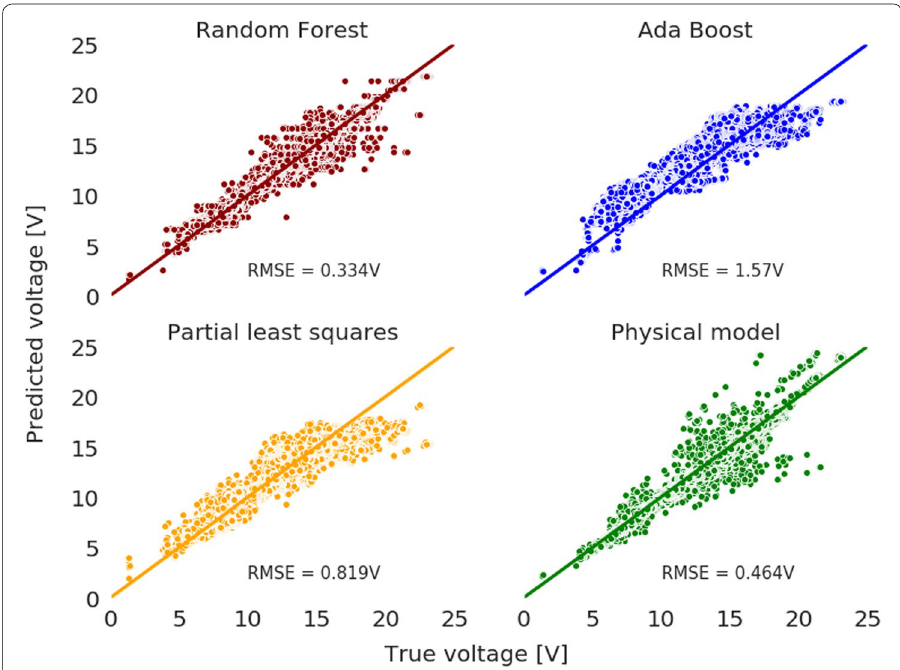
Fig. 7 Prediction error plots of the four models presented on the validation set with the respective RMSE results. Top left) Random Forest regression; top right) Ada Boost regression; bottom left) Partial Least Squares regression; bottom right) Physical